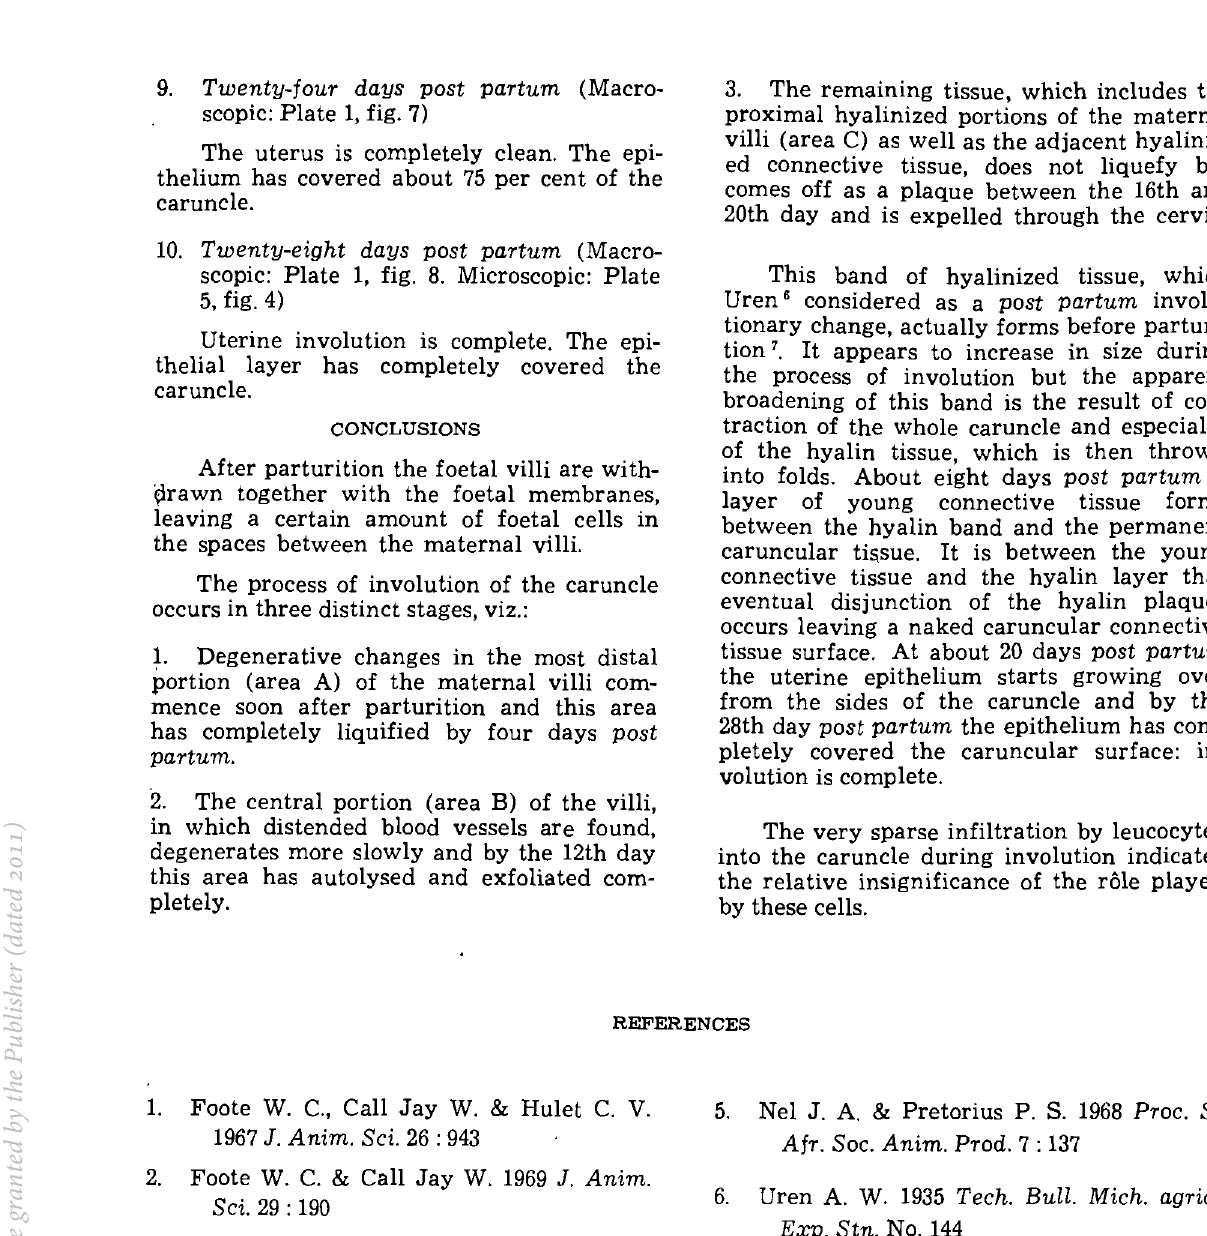
3. The remaining tissue, which includes the proximal hyalinized portions of the maternal comes off as a plaque between the 16th and 20th day and is expelled through the cervix.